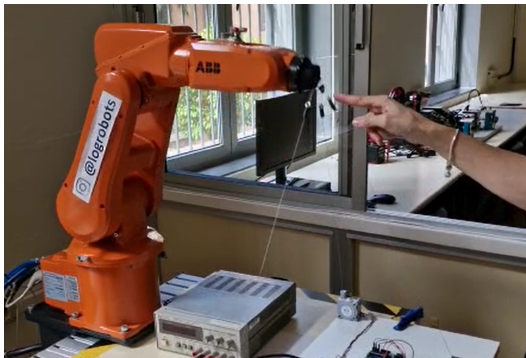
Figure 14. Snapshot of test